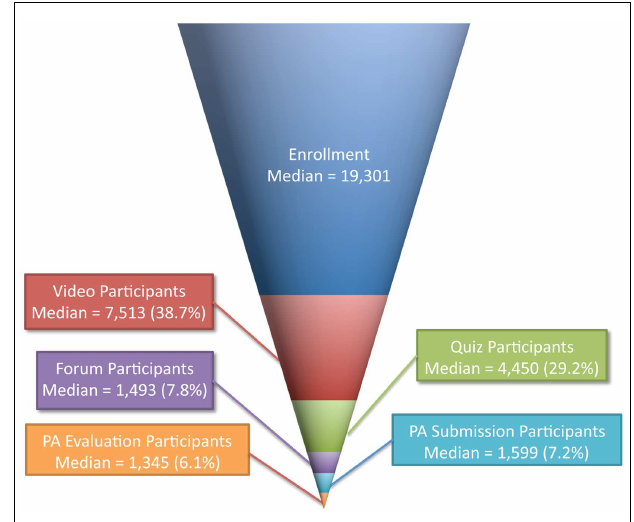
FIGURE 4 | Funnel of participation in four JHSPH MOOC offerings with peer assessment assignments